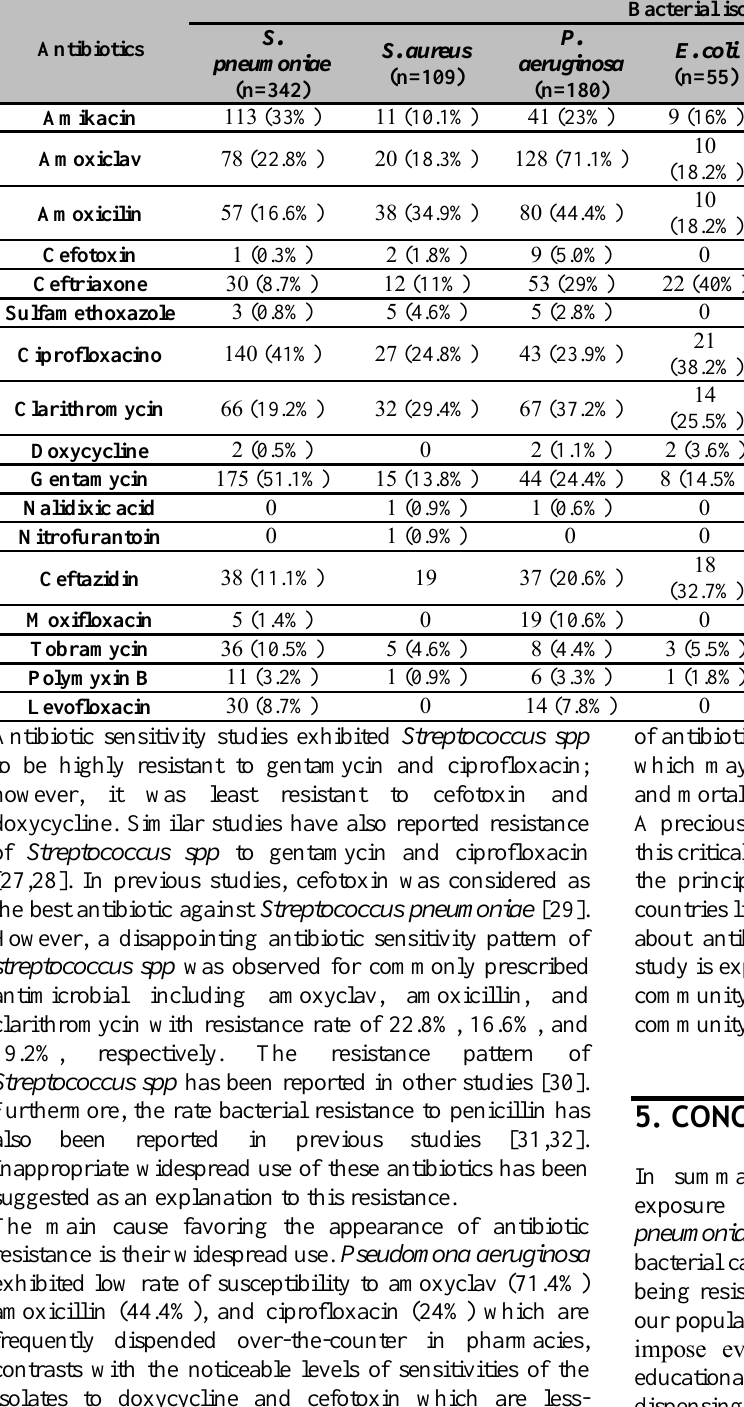
Table 2. Resistance pattern of the isolated bacteria to tested antibiotics Antibiotics